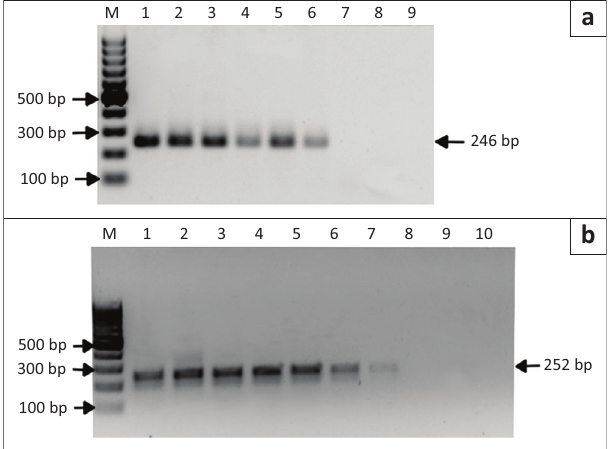
FIGURE 2: Detection of serial dilutions of plasmid DNA by nested polymerase chain reaction. (a) Lanes 1–8: 10-fold serial dilutions (2.5x10 7 – 2.5x10 0 copies) of Anaplasma marginale plasmid DNA (clone F48a; msp1 β gene); lane 9: water negative control. (b) Lanes 1–9: 10-fold serial dilutions (2.5x10 8 – 2.5x10 0 copies) of Anaplasma centrale plasmid DNA (clone 9410i; msp2 gene); lane 10: water negative control. M: 100 base pair marker; numbers on the left and right indicate molecular sizes in base pairs.